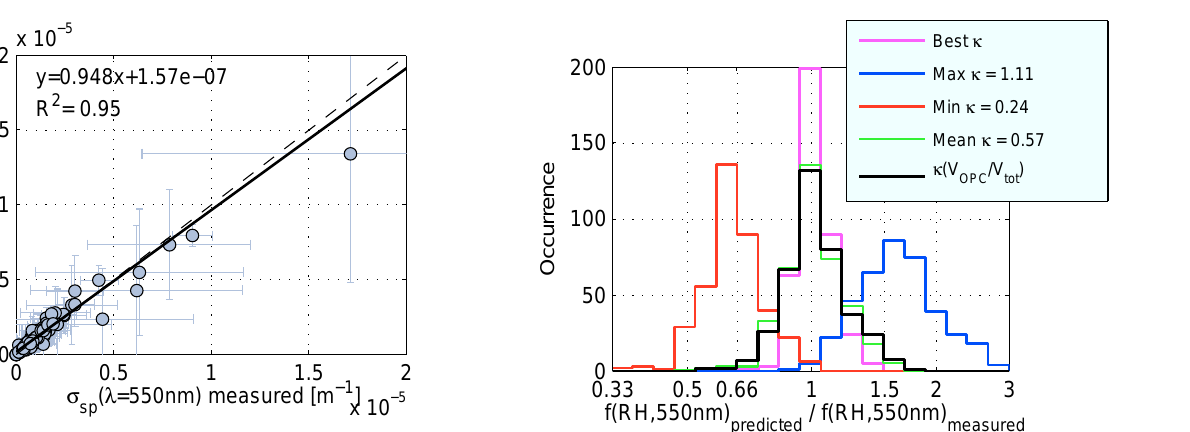
Fig. 12. Histogram of predicted to measured f ( RH, λ = 550nm) within RH = 75–95% using the minimum ( κ = 0.24, red line), the maximum ( κ = 1.11, blue line), and the mean ( κ = 0.57, green line) κ obtained from the backward calculations as well as κ as a function of the volume fraction of large particles V OPC /V tot (black line). Using the exact daily mean κ derived from the backward calculation is also shown for comparison (magenta